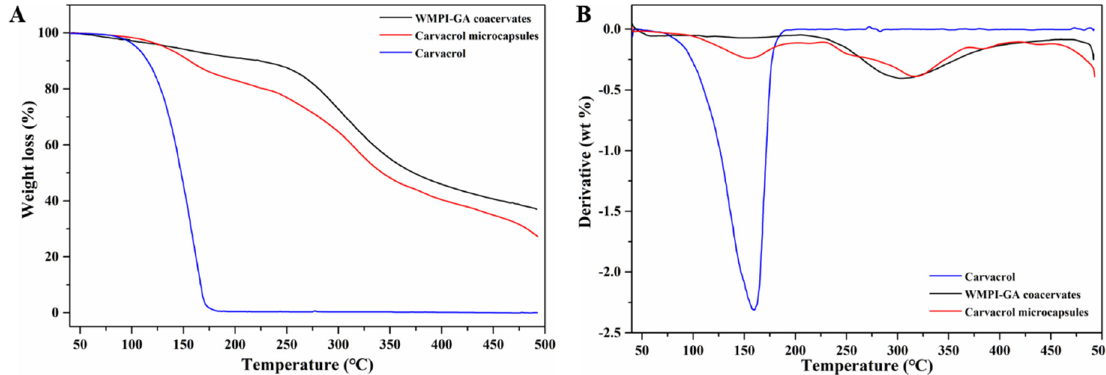
Figure 7. TGA ( A ) and DTG ( B ) curves of carvacrol, WMPI-GA coacervates, and carvacrol microcapsules.